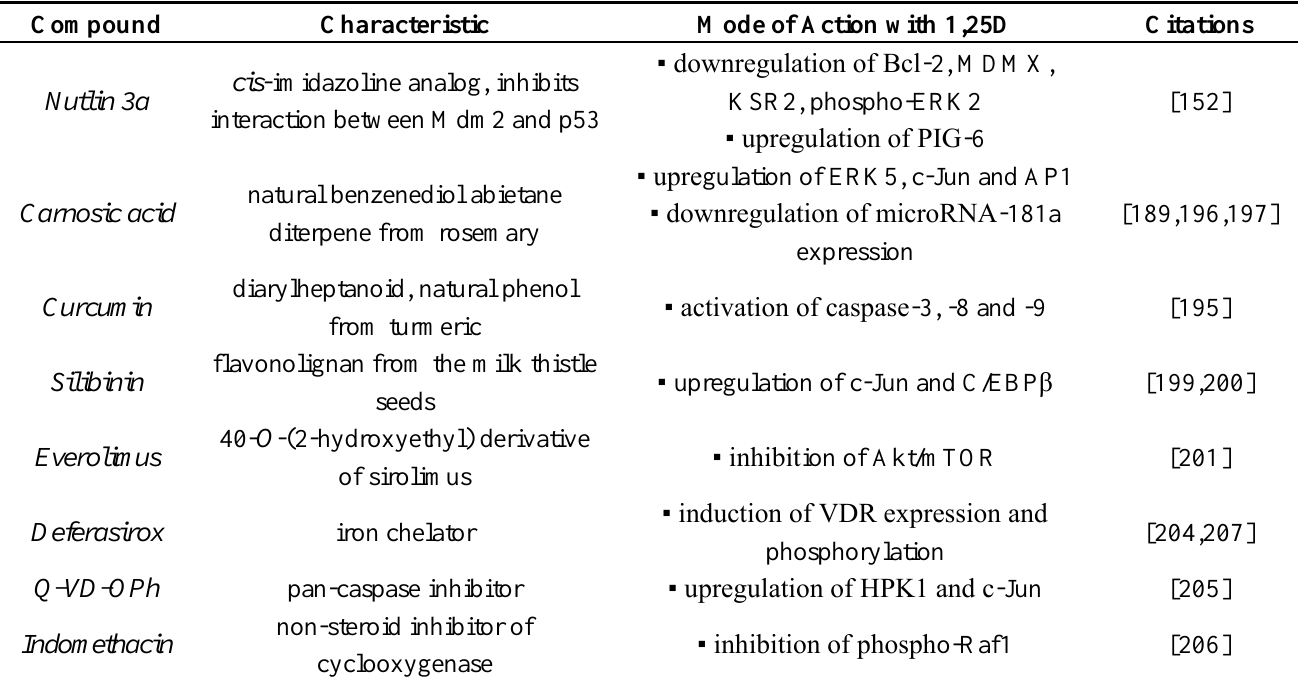
Table 1. Examples of potentiators of 1,25D-induced differentiation of AML cells.